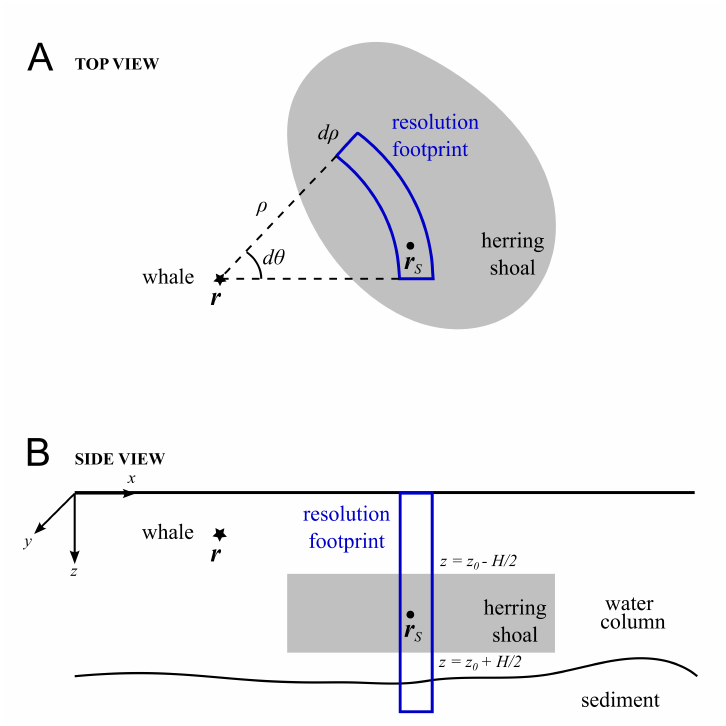
Figure 2. Top view ( A ) and side view ( B ) of the geometry for possible acoustic remote sensing in a continental shelf environment by baleen whales. The resolution footprint given baleen whale acoustic parameters is an annular sector with range extent d ρ and cross-range extent ρ d θ